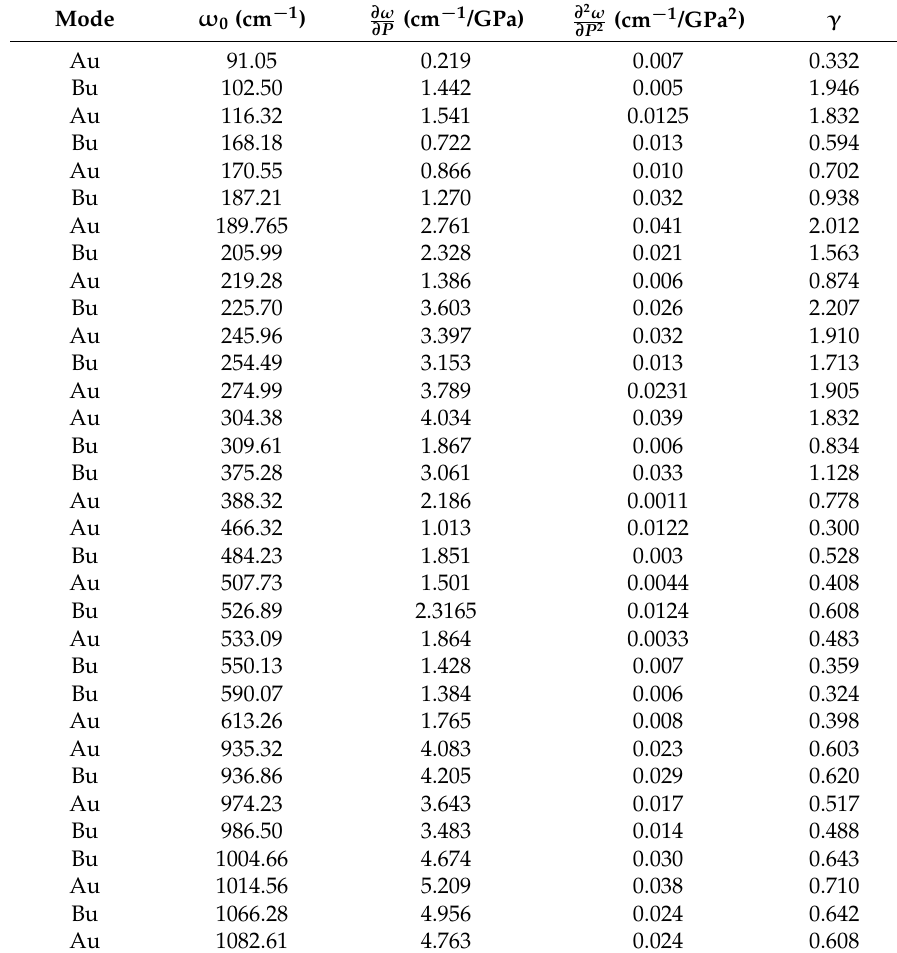
Table 7. Infrared frequencies at ambient pressure, their pressure coefficients, and Grüneisen parameters ( γ ). The pressure dependence of frequency has been fitted with a second order